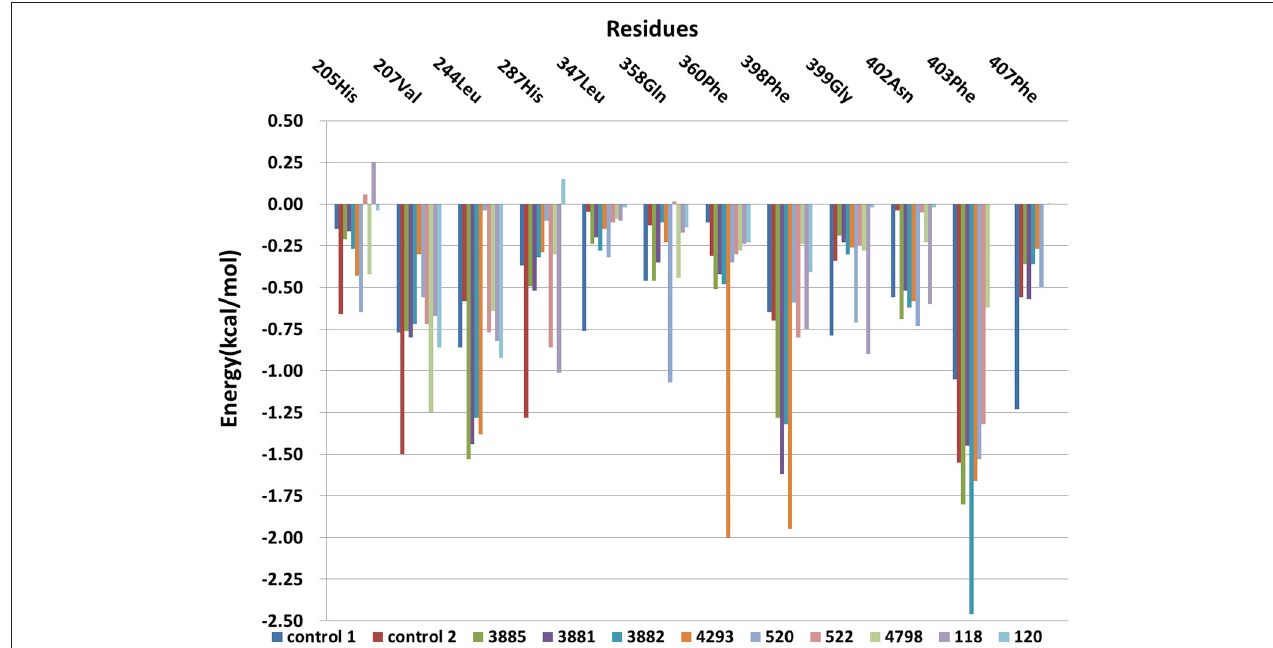
FIGURE 12 | The Per-residue contributions of HPPD to ligand combination.